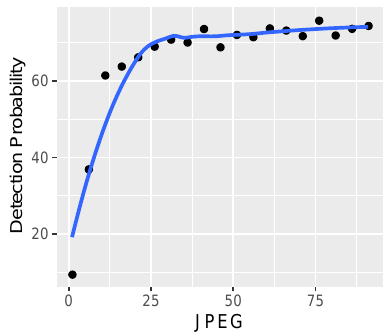
Figure 10. Face recognition detection [probability] for different levels of JPEG compression [quality